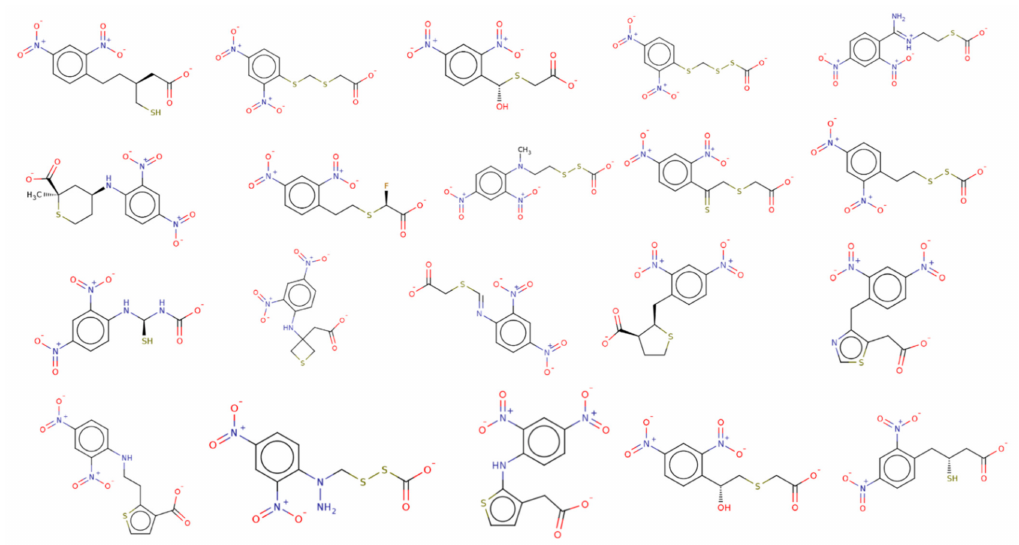
Figure 8. The top 20 chemotypes derived from the parent RJC02337 from Bio-isosteric